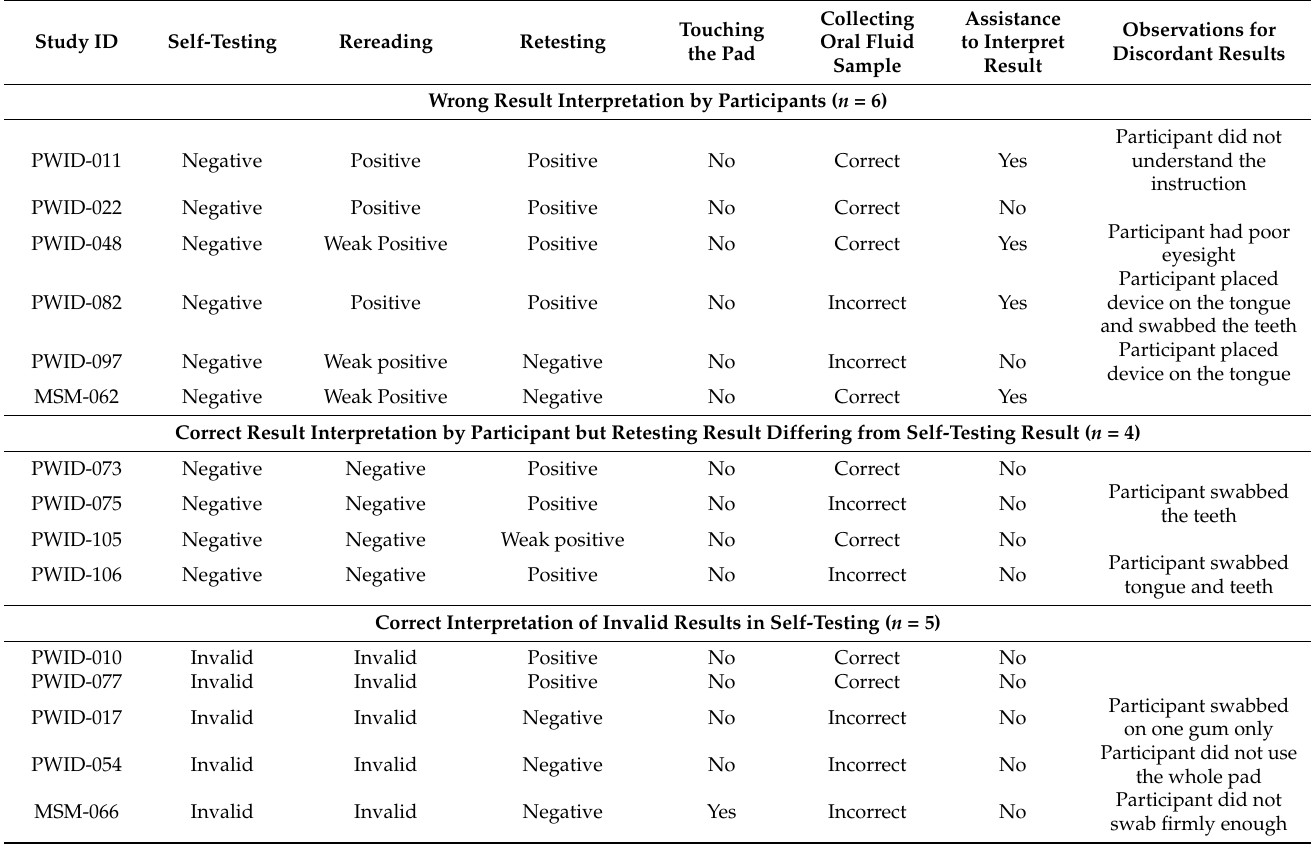
Table 6. Discordant results among self-testing, rereading (interpreted by study staff) and retesting (by the study staff) in PWID and MSM